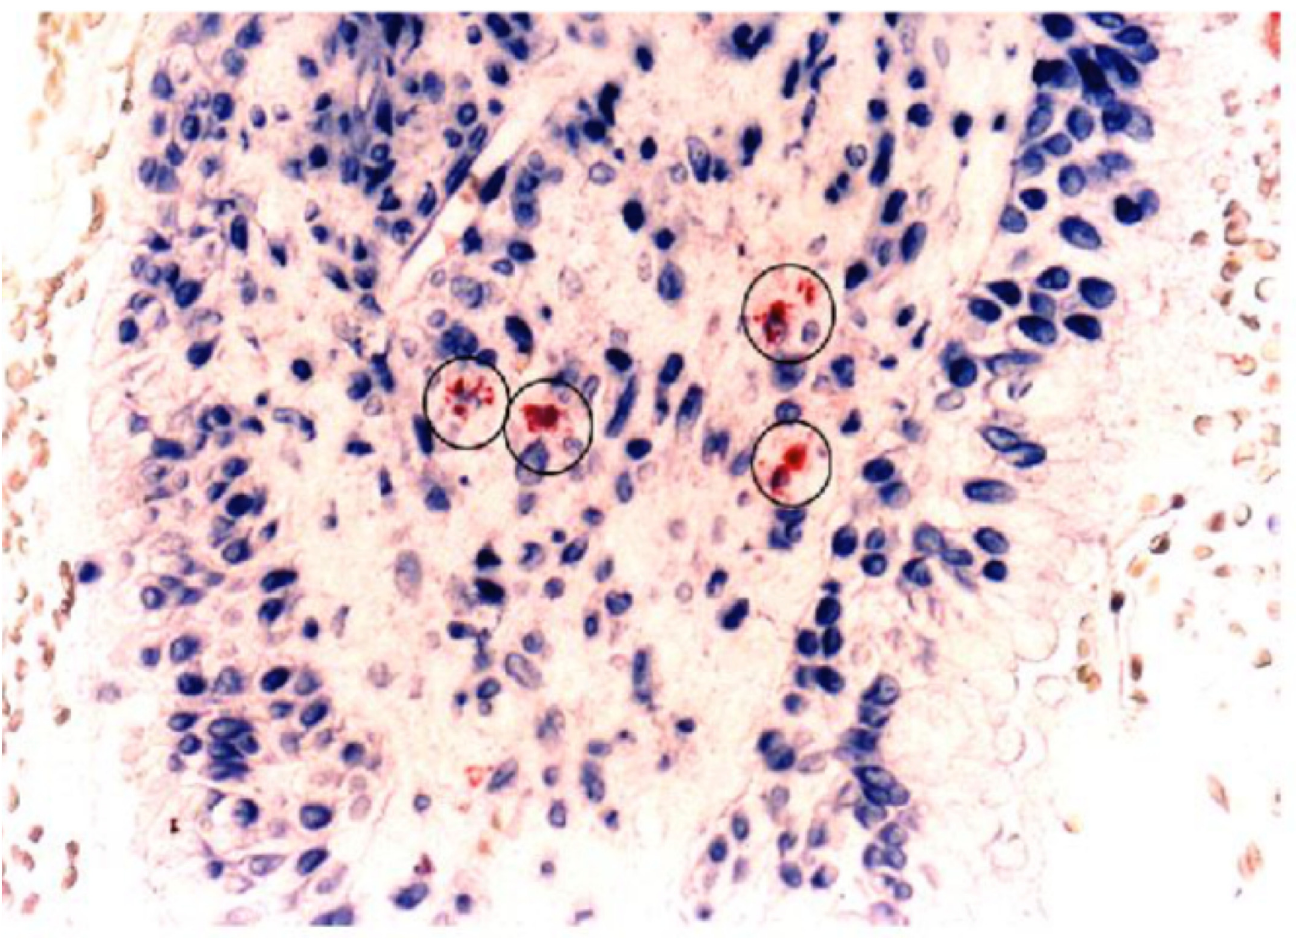
Figure 5. Mast Cells in Middle Ear Mucosa Biopsy [51] Antitryptase antibody (AA1) staining of mast cells (circled) (Adopted from: Hurst DS, Amin K, Sevéus L, Venge P. Evidence of mast cell activity in the middle ear of children with otitis media with effusion. Laryngoscope 1999 , 109 , 471–477; with permission From Lippincott Williams & Wilkins, Inc.).